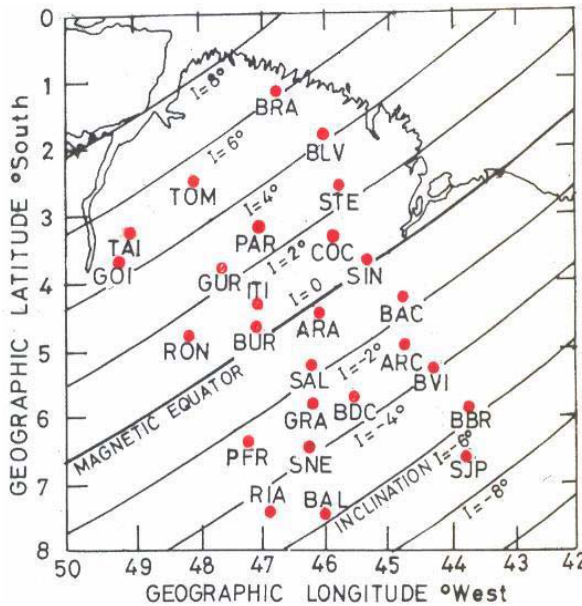
Fig. 1. Map showing the geographic locations of the stations whose data are used for analysis. The lines of constant “Inclination” are also